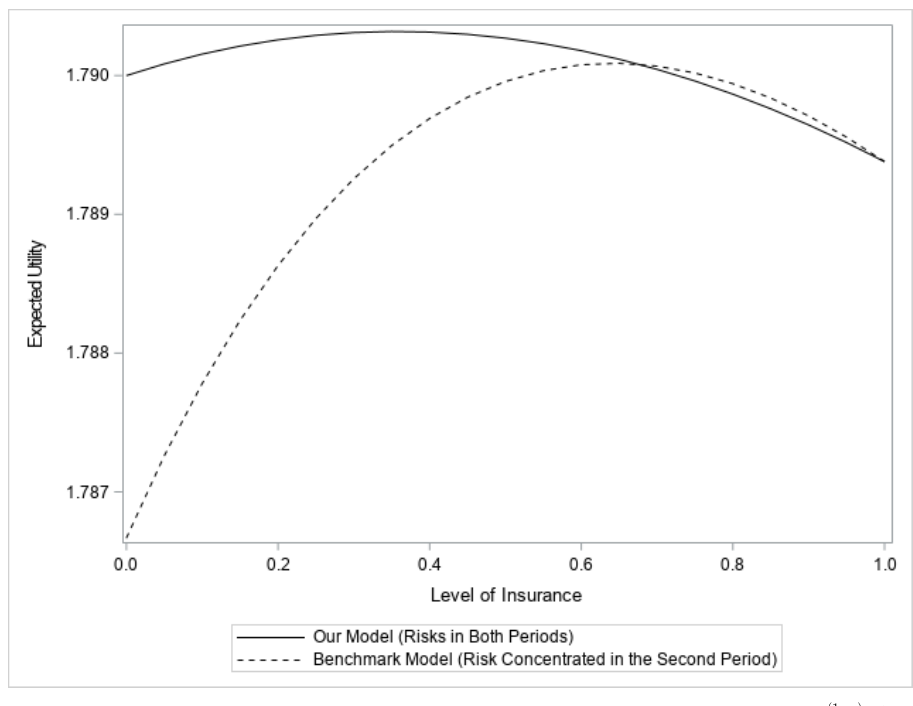
Figure 1. A Comparison between the two frameworks (w/o saving): u ( x ) = x ( 1 − γ ) − 1 L = 2 l = 4; q = π = δ = 0.2; λ = 0.2; γ =